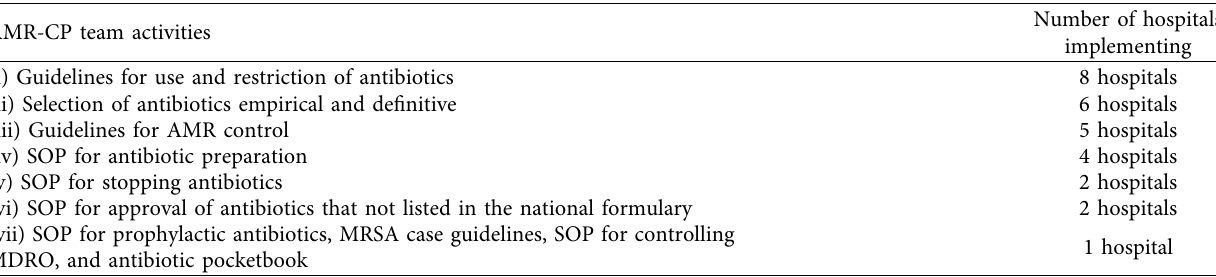
Table 3: Types of guidelines and standard operating procedures (SOPs) that have been prepared by the AMR-CP team in 10 hospitals in Indonesia, in